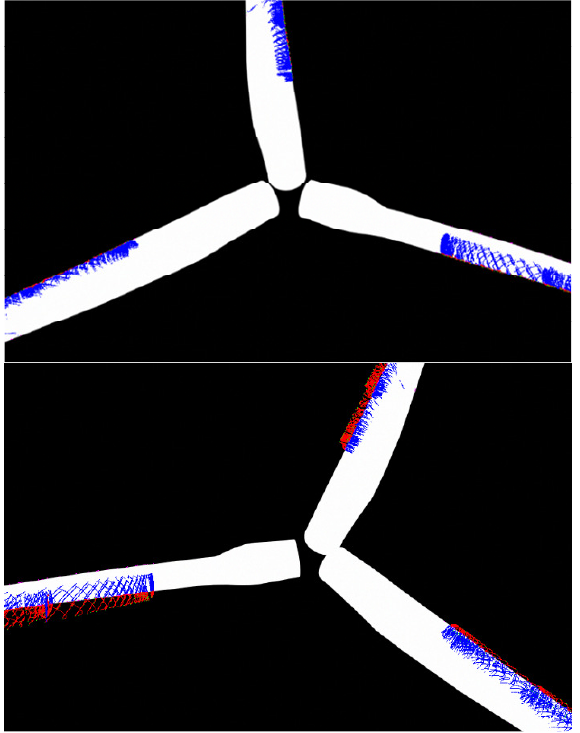
Figure 6. Visualisation of the matching between laser scanner profiles and silhouette. Red points are outside the silhouette and blue points are inside. The final result is shown in the top image. An overlay with start values is shown in the bottom